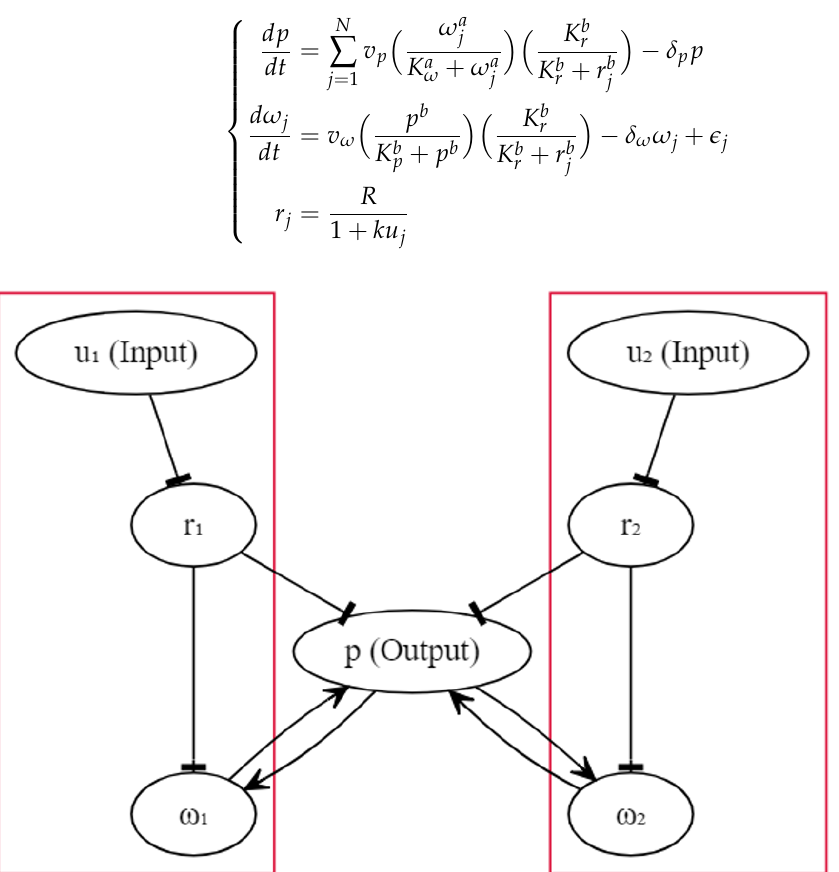
Figure 1. The schematic circuit of Fernando’s model. In the equations above, u 1 and u 2 represent the respective concentrations of the unconditioned and conditioned stimuli, and they are given to the cell in a transient time window. ω 1 and ω 2 represent the respective concentrations of the weight molecules. r 1 and r 2 represent the respective concentrations of the repressor molecules. The concentration of the response molecule is denoted by p . K ω , K r and K p denote the respective Hill constants for molecule ω , r and p that measure the concentrations of the transcription factors required for half occupancy. R denotes the repressor concentration in the absence of molecule u . a and b are Hill coefficients that measure the cooperativity of the respective transcriptional factors. In [53], the authors used a = 4 and b = 2; however, in this work, we study the impact of varying integer values of a and b on qualitative behaviours. (cid:101) denotes the basal grow rate, and we assumed that it was only nonzero for j = 1. v and δ denote the